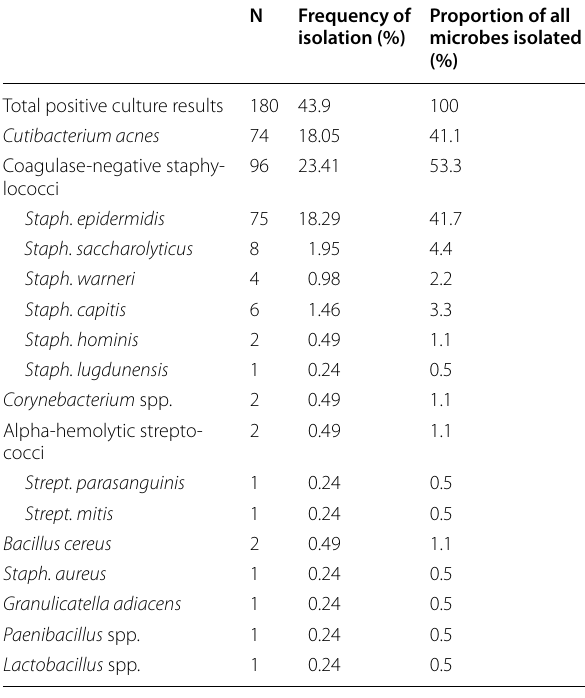
Table 3 Number and frequency of all isolated